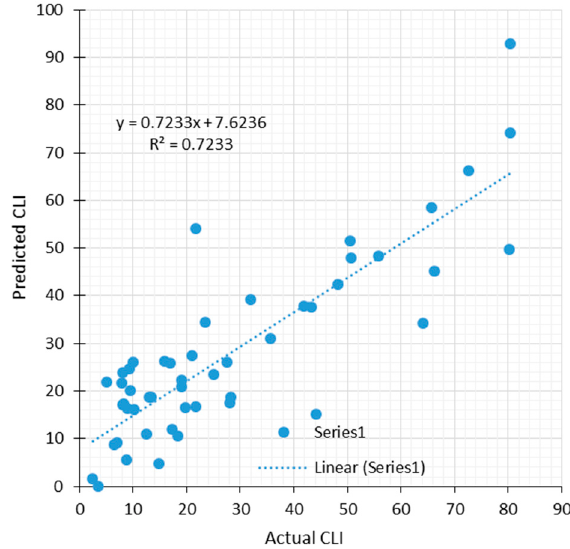
Figure 12. Relations between the measured CLI and predicted CLI for training (model 1 ‐ NLMRM).